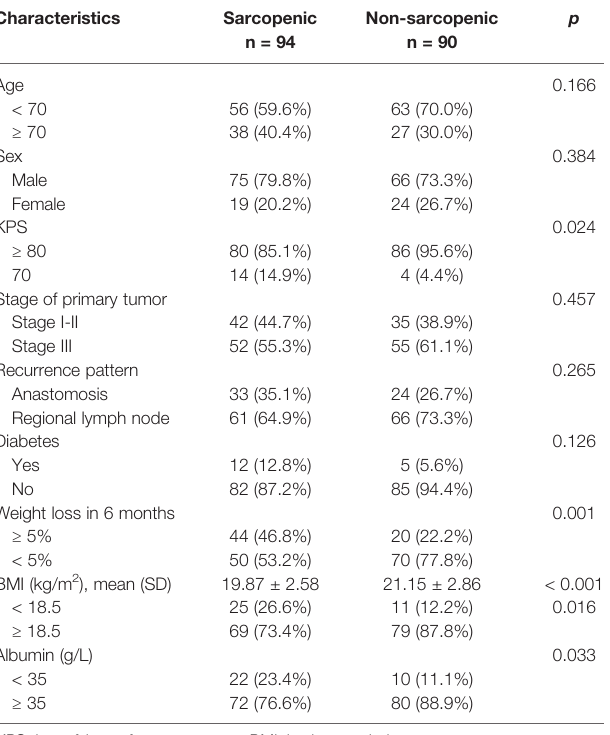
TABLE 2 | Comparisons between patients with and without sarcopenia. Characteristics